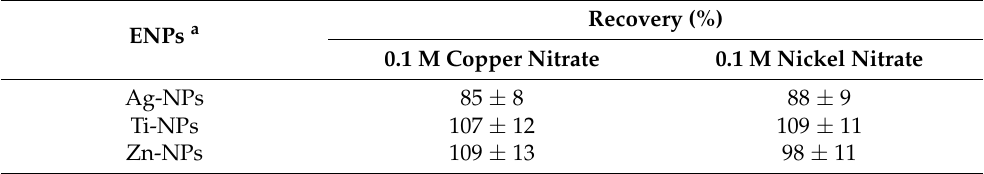
Figure 1. Sample preparation for the ICP-SFMS analysis. Table 2. Recovery of selected ENPs from seawater after using the different preconditioning agents.